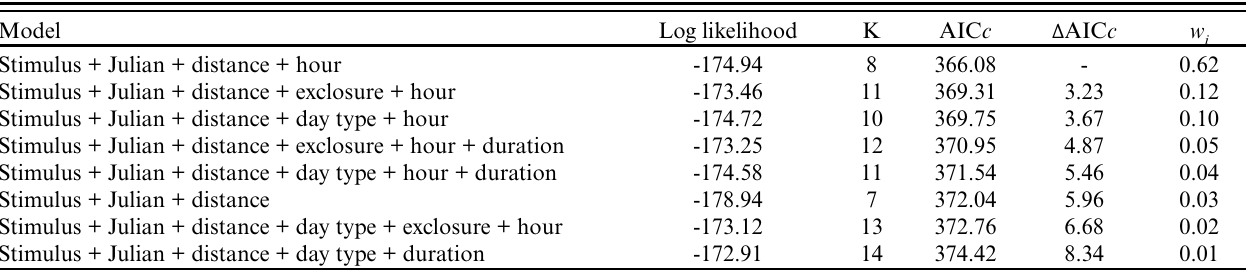
≥ 0.01 are listed. i